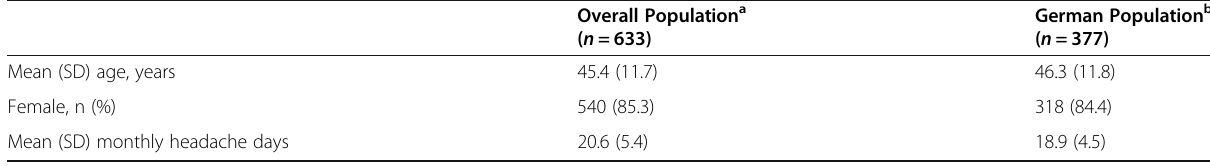
Table 1 Baseline demographic and migraine characteristics of patients in the REPOSE study (overall and German